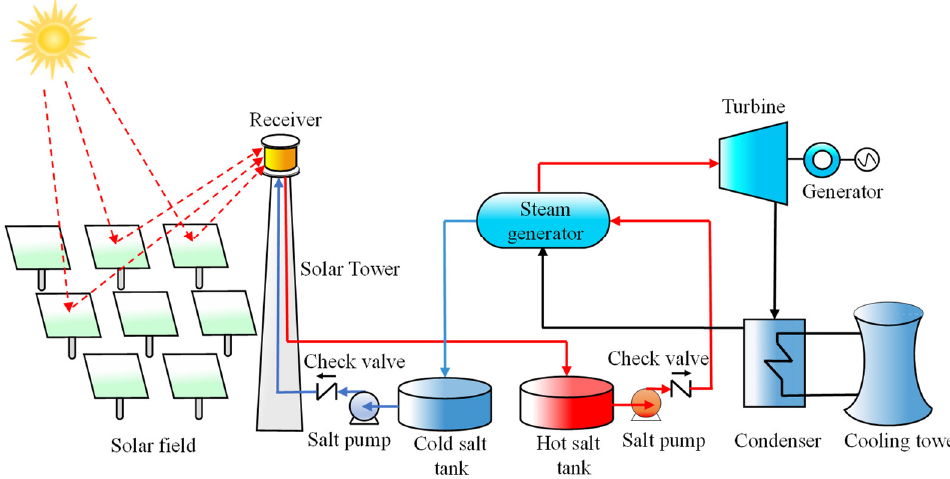
Figure 1. Tower-type molten salt cogeneration system.